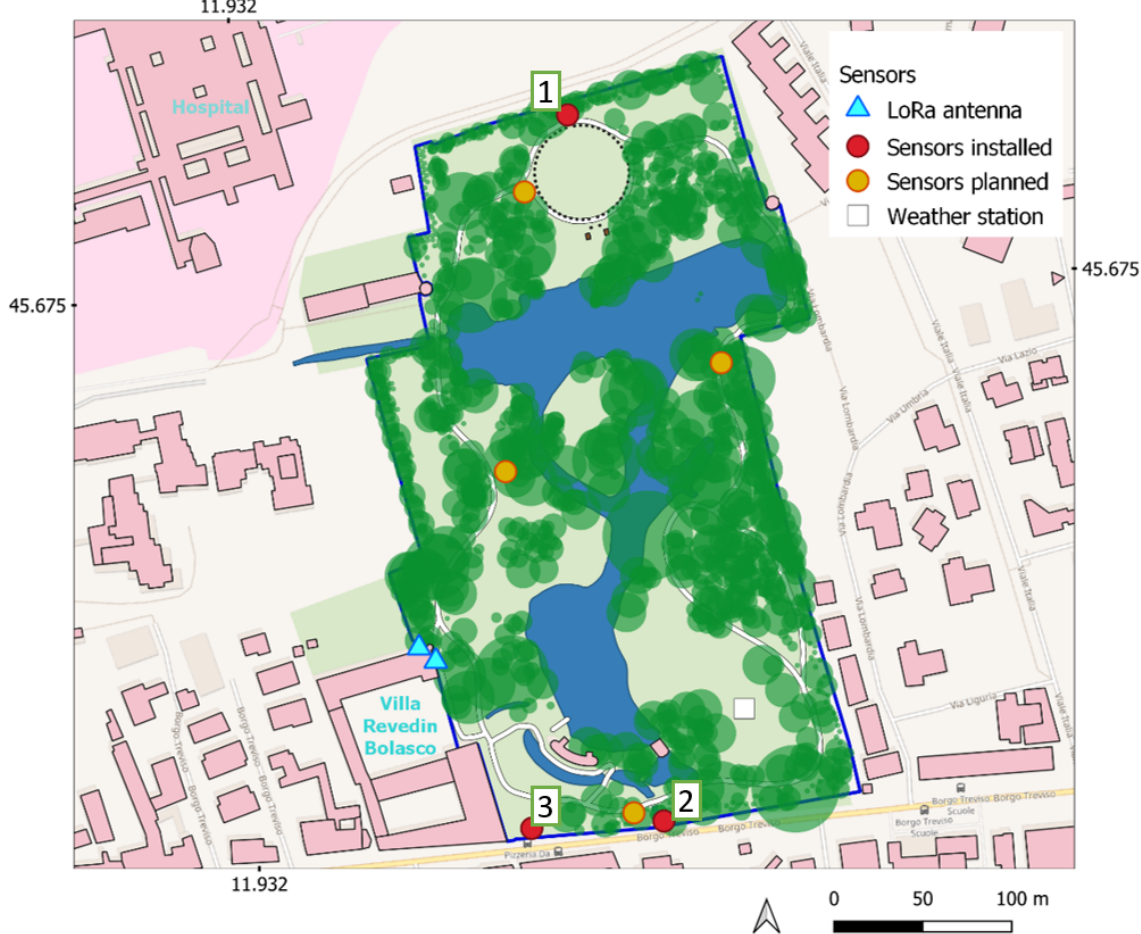
Figure 1. Study area (Villa Revedin Bolasco) with locations of the devices with climate, weather, noise, and air quality sensors and LoRaWAN antennas. Multiple sensors have been installed in the locations labelled 1, 2 and 3. Green circles are the tree canopies.